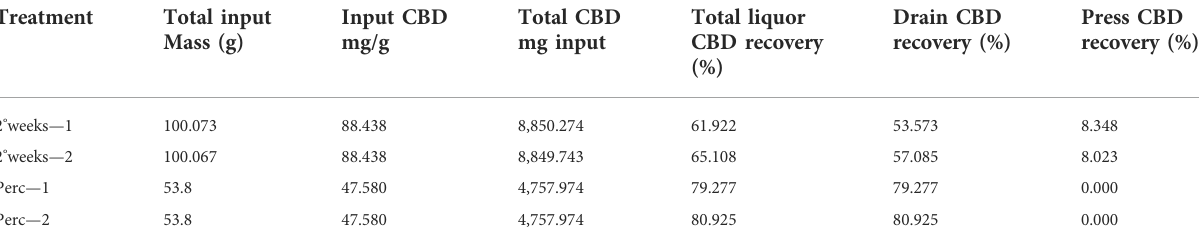
TABLE 3 CBD recovery ef fi ciency (% recovery) per extraction treatment.